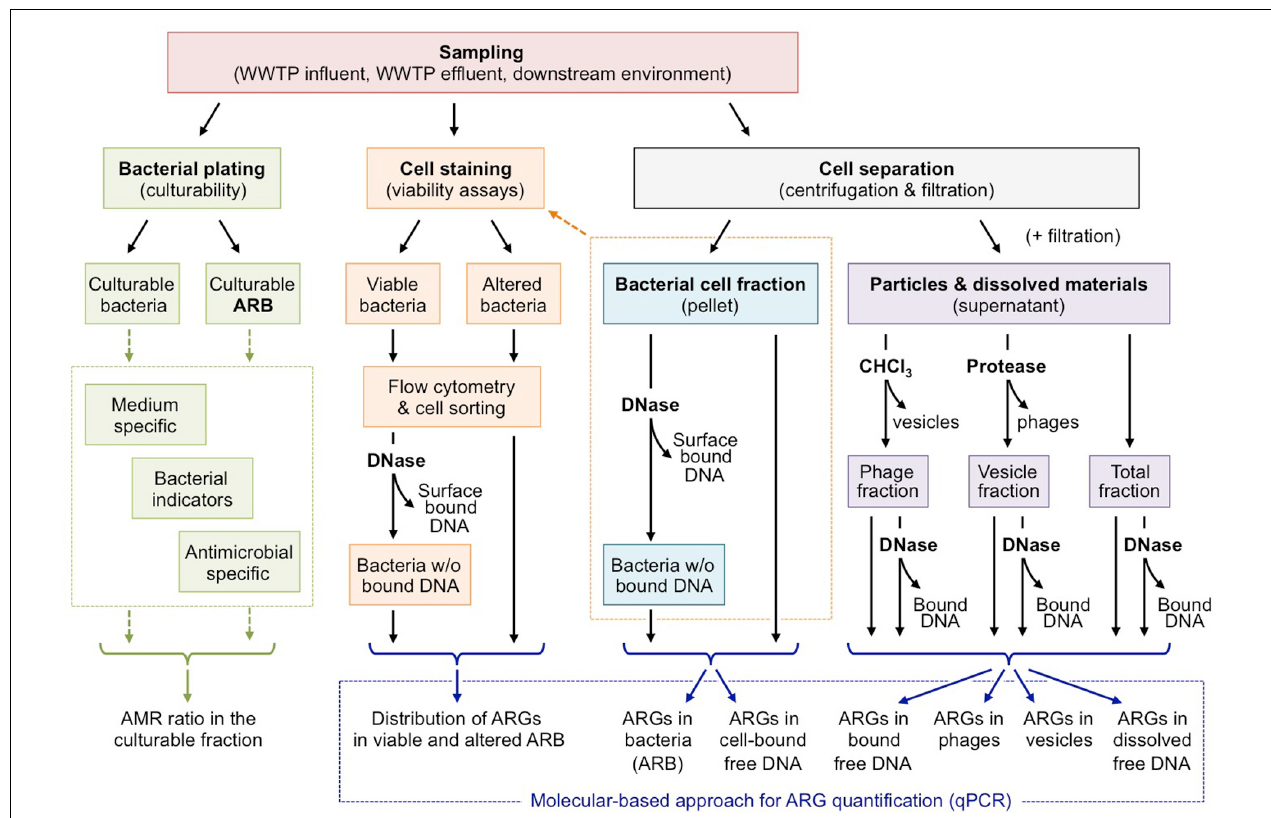
FIGURE 2 | Assessing the distribution of ARGs in the different compartments of wastewater effluents. As stated by Biller et al. (2017) or Soler et al. (2015) MVs and phages remain difficult to separate. This figure should be understood as a working